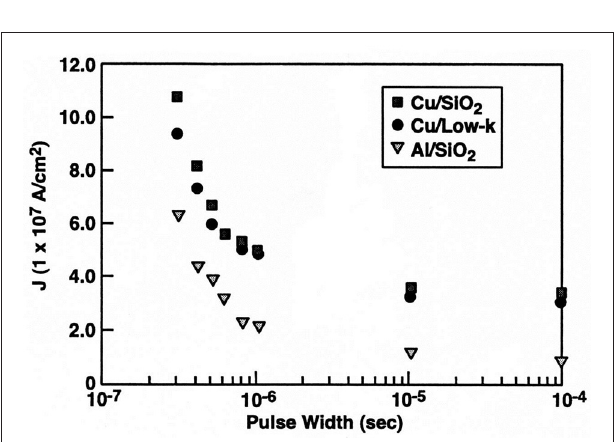
FIGURE 10 | ESD robustness of interconnects in low-K material in a 130nm CMOS technology (with permission of the ESD